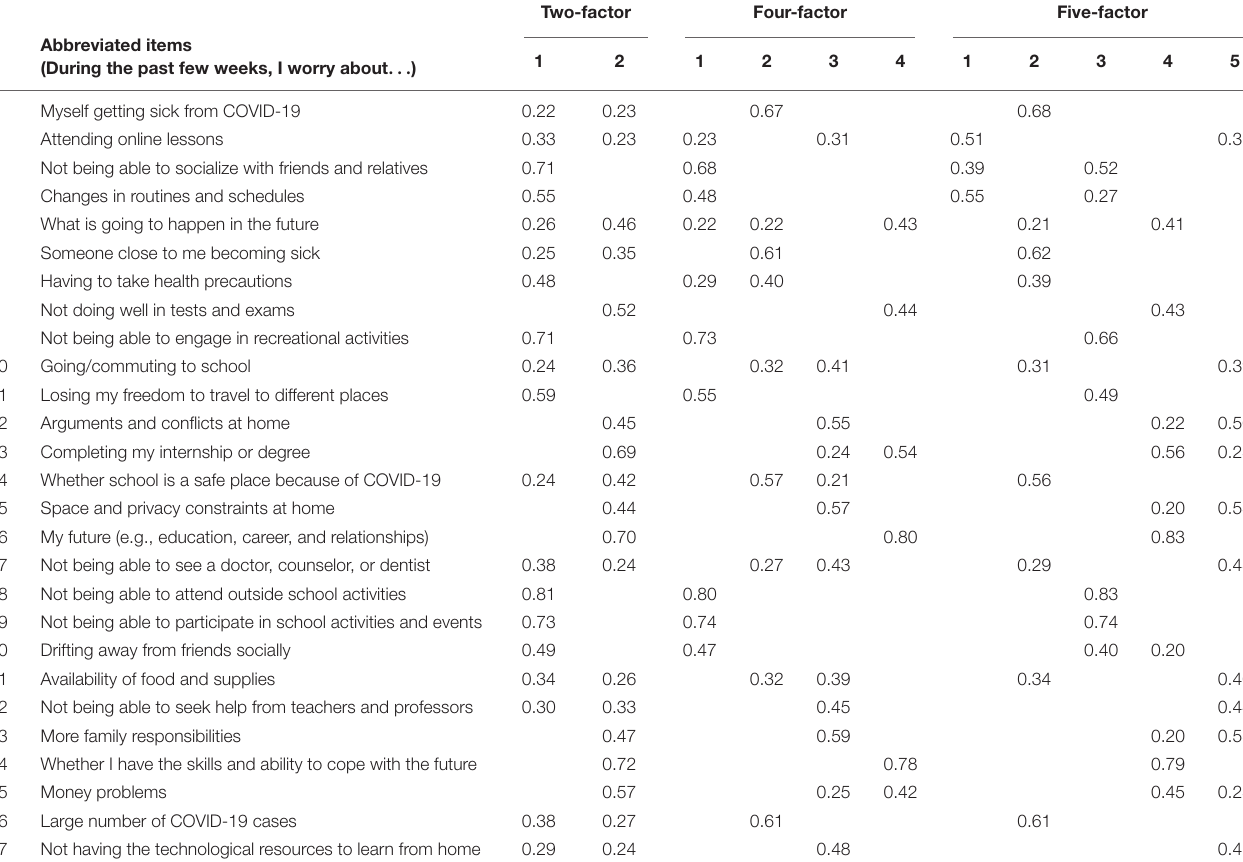
TABLE 1 | Standardized pattern coefficients for the two-factor, four-factor, and five-factor solutions in the first round of EFAs. Two-factor Four-factor